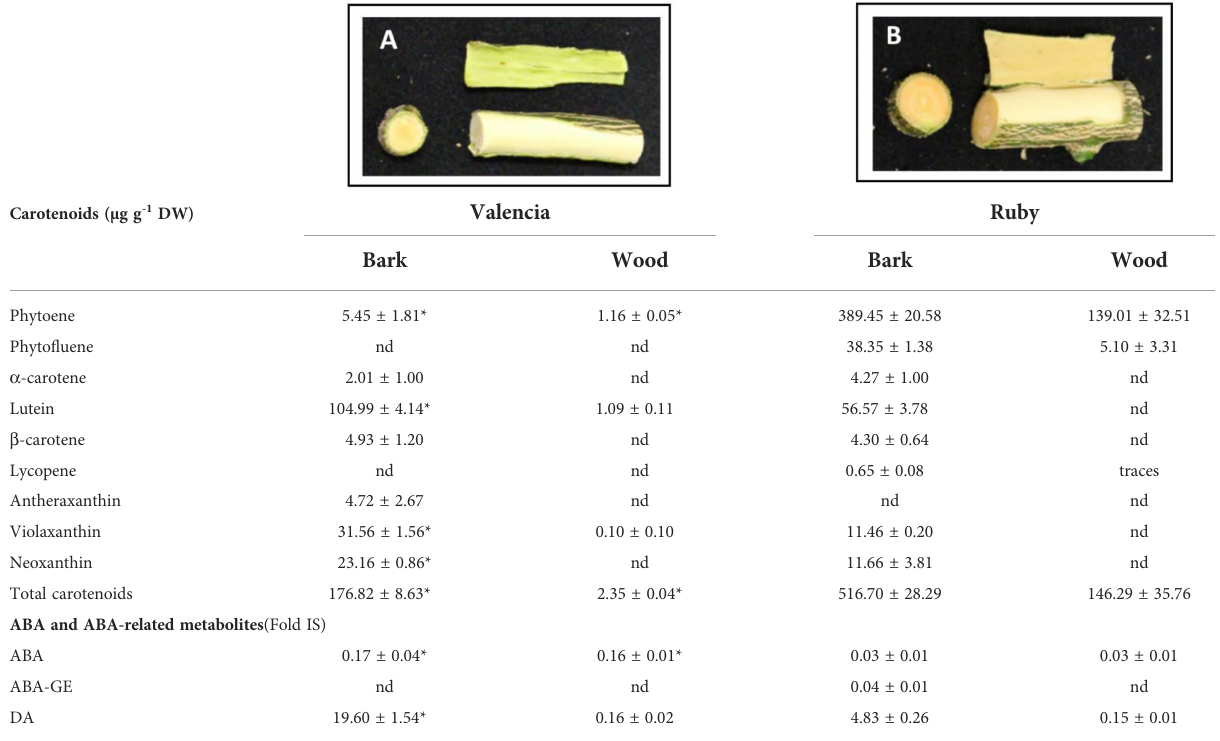
Carotenoids (µg g -1